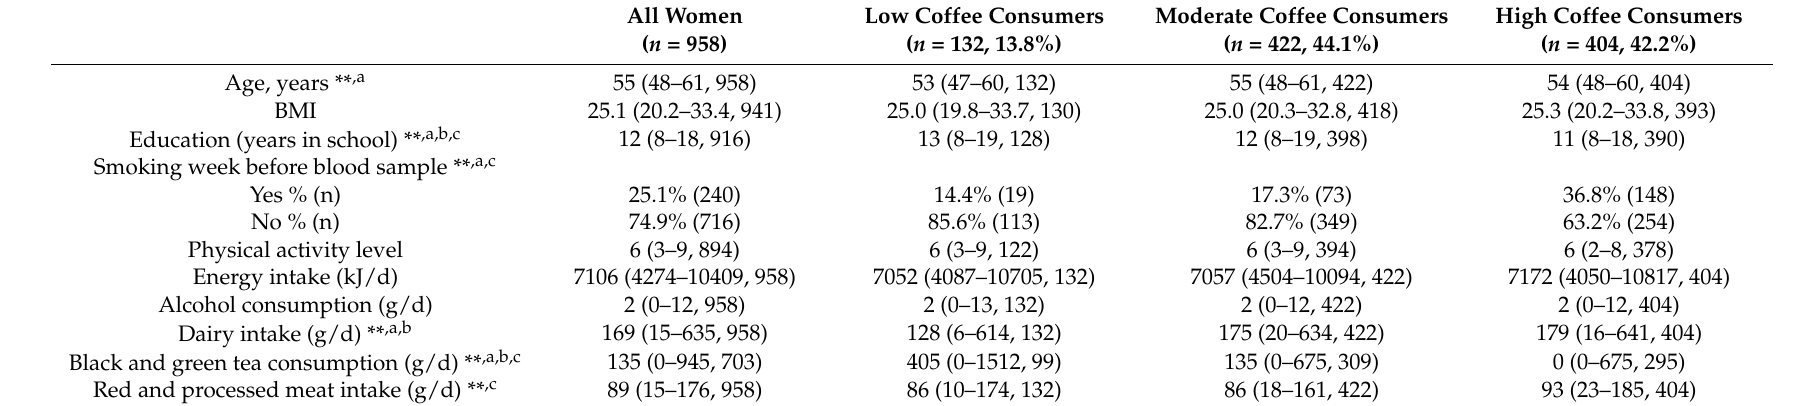
Table 1. Descriptive statistics of “all women,” low coffee consumers, moderate coffee consumers, and high coffee consumers.